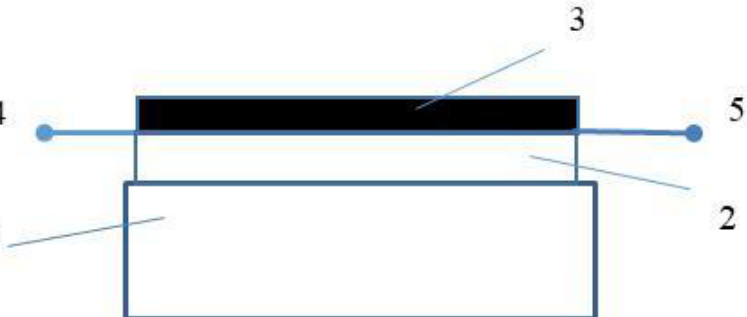
Figure 10. Schematic diagram of the surface-type shockproof NiPc – CNT – oil – rubber composite sample: rubber substrate (1), CNT – oil jelly (2), NiPc – oil jelly (3), terminals (4 and 5).